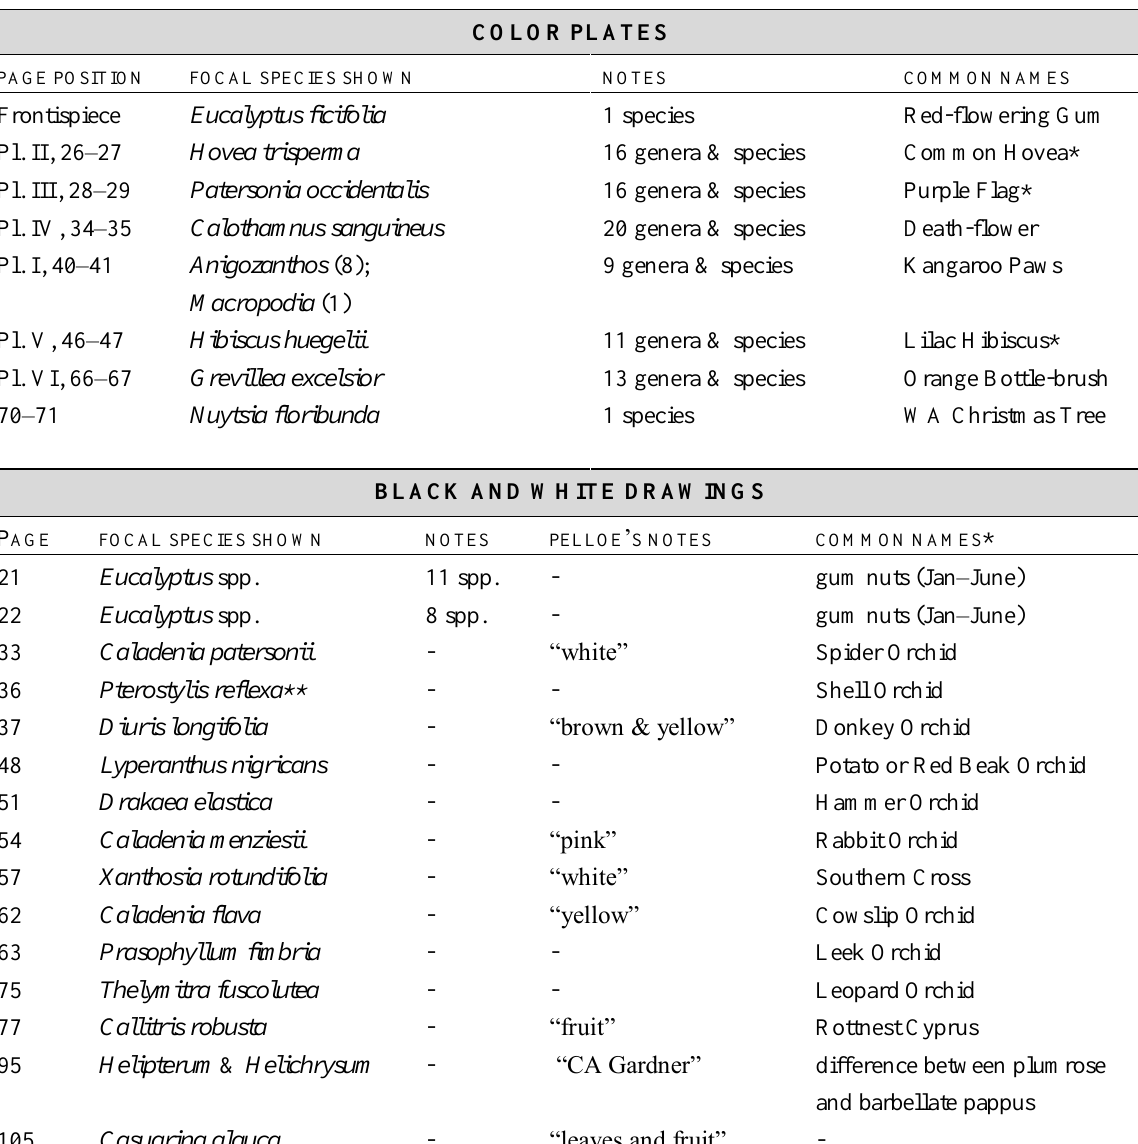
Table 1. Summary of Emily Pelloe’s Wildflowers of Western Australia (1921). Pelloe lists the scientific and common names for most of the plants she illustrated. In three instances, marked with a single asterisk, Pelloe does not provide common names. Hence the common names of these three plants (Common Hovea, Purple Flag and Lilac Hibiscus) have been cited from the online taxonomic repository, FloraBase [24]. Additionally, according to FloraBase , Pterostylis reflexa (marked with a double asterisk) has been renamed Diplodium reflexum